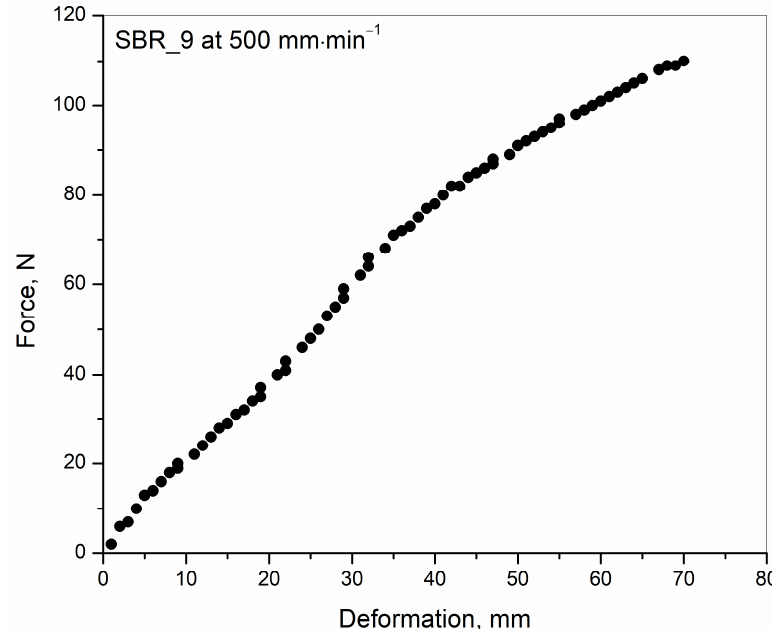
Figure 3. Plot of force versus deformation for the sample SBR_9.0 at a deformation speed of 500 mm, min −1 was used for the calculation of tearing energy.